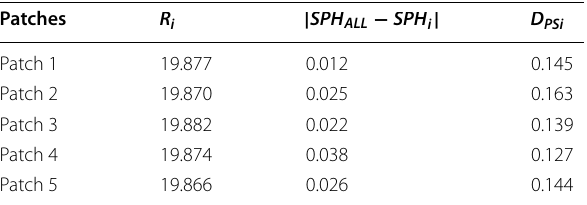
Table 3 Biggest distance from the points on each data patch to the fitted sphere (mm) Patches